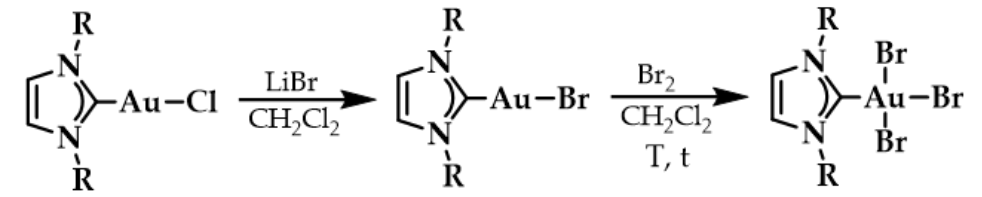
Figure 10. Synthesis of [AuBr 3 (NHC)]